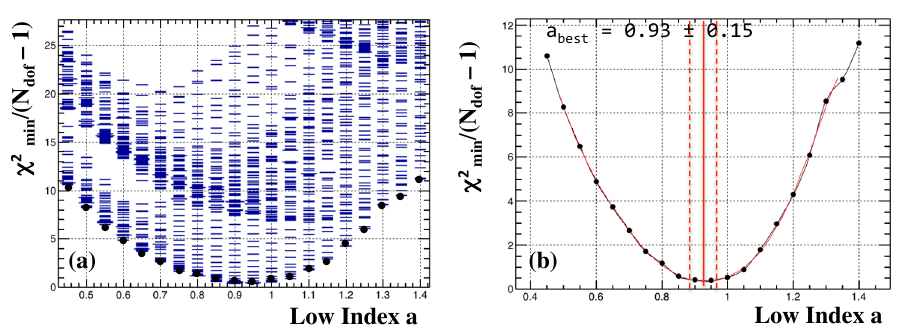
Figure 1. (a) Distribution of the χ 2 of the parameter a . The black dots indicate the χ 2 the same data set as in (a). x best and errors are shown as solid and dashed lines,